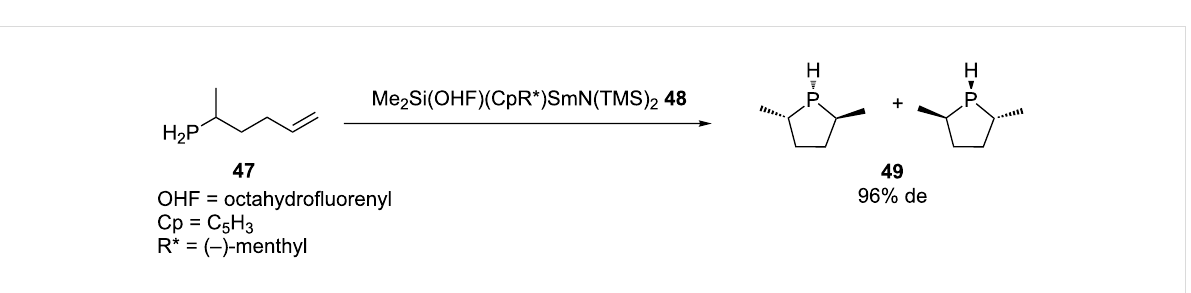
Scheme 15: Intramolecular hydrophosphination of phosphinoalkene 47